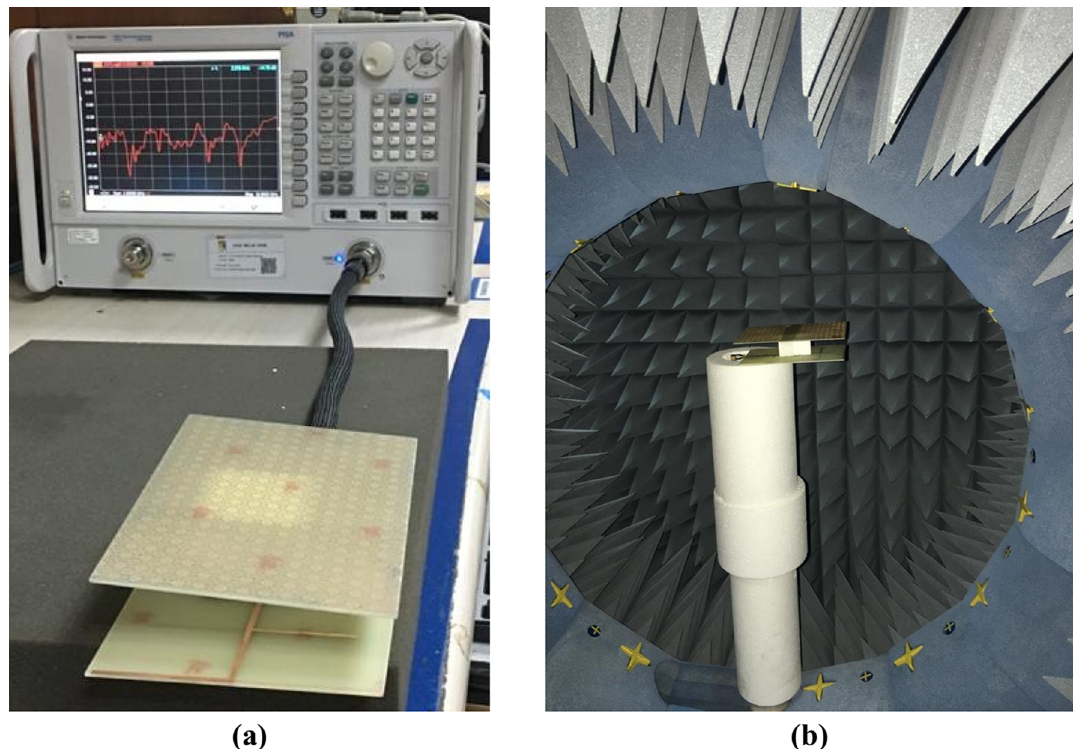
Figure 36. ( a ) Measurement set up for S 11 and VSWR using VNA ( b ) Measurement setup for gain, efficiency, and radiation pattern using SATIMO near field measurement